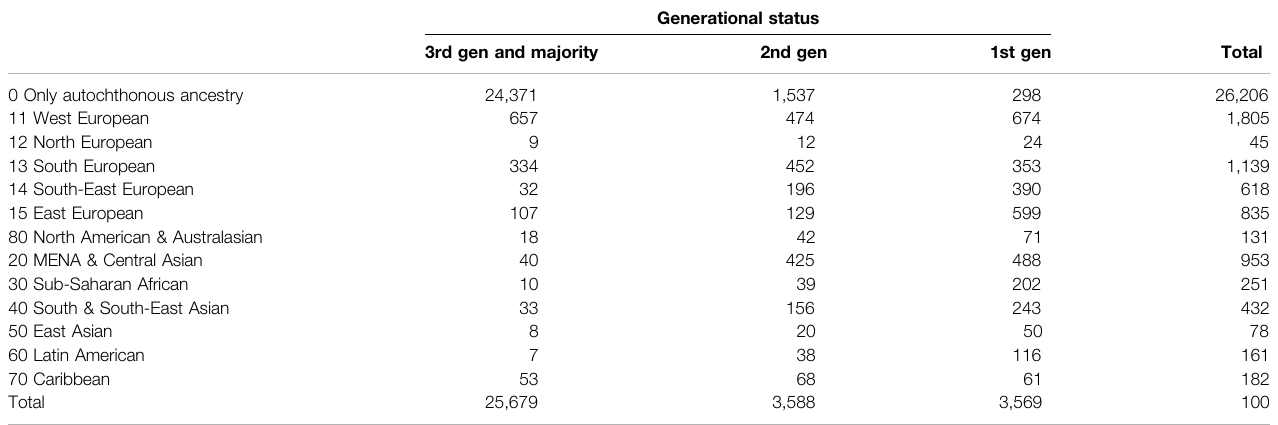
TABLE 3 | Joint distribution of socio-cultural origin and generational